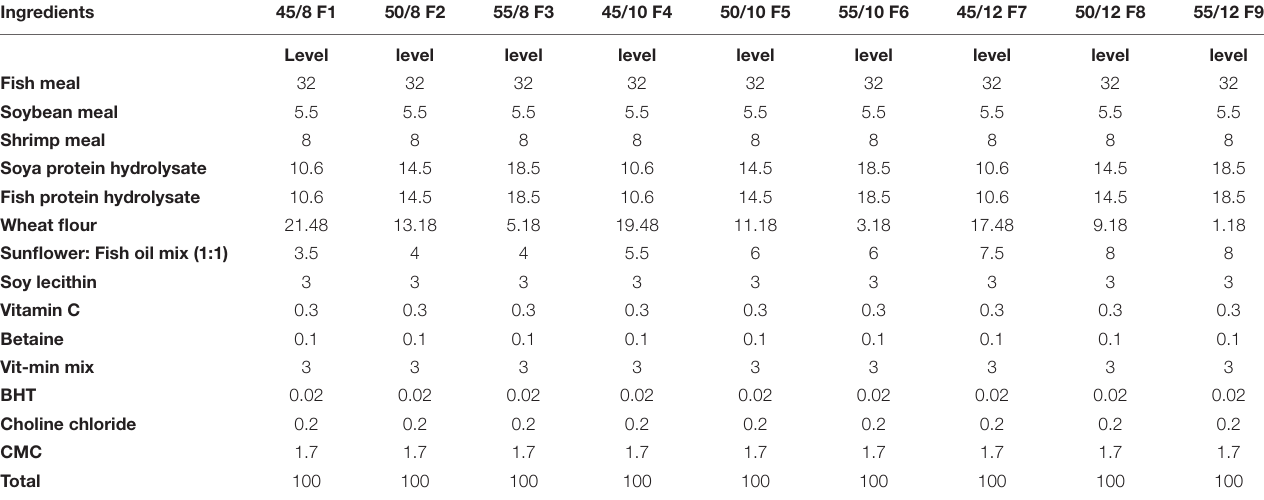
TABLE 2 | Composition of the Experimental Diets (%